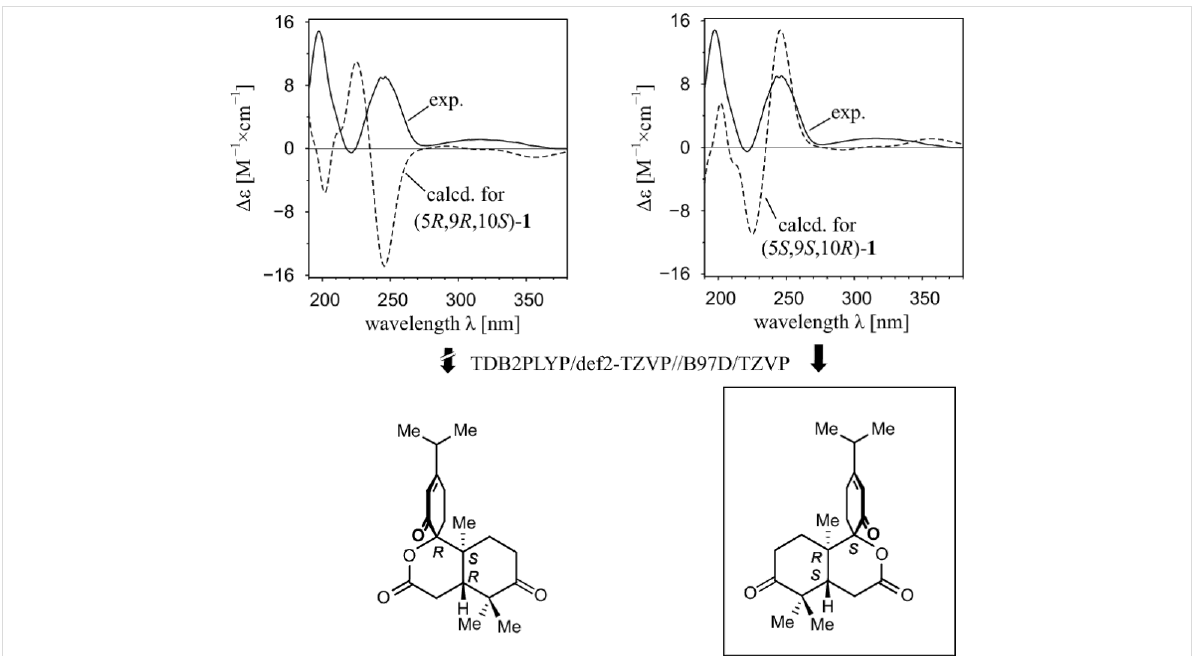
Figure 4: Determination of the absolute configuration of decandrinin ( 1 ) by comparing the calculated CD spectra with the experimental one.